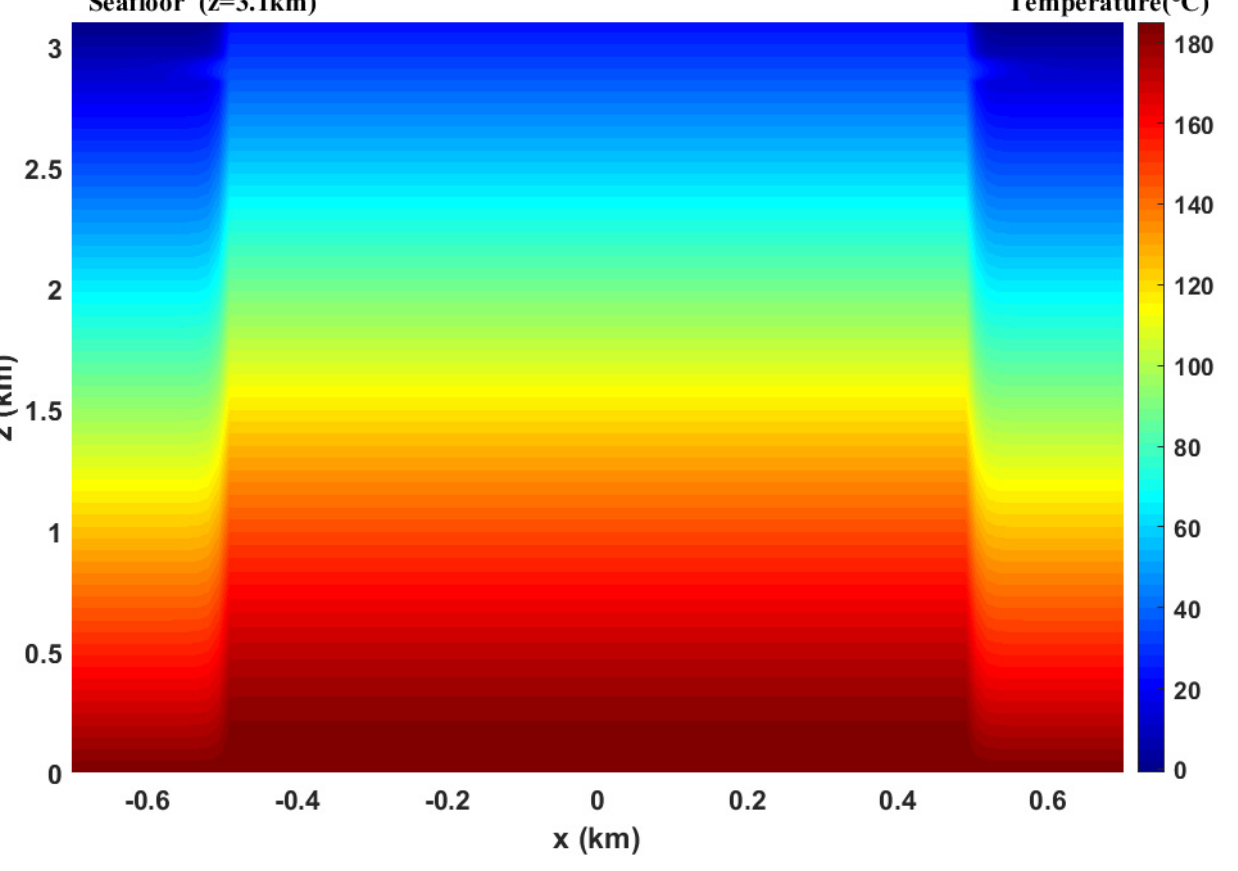
Figure 6. Simulation results of mud volcano thermal fluid invading the hydrate occurrence layers and its influence on the hydrate layers’ temperature field. Setting 140 to 220 meters as the hydrate occurrence layer, the simulation results indicated that the heat conduction effect of the thermal fluid on the hydrate layers was significantly enhanced, and the temperature distribution curve is noticeably convex towards both sides.